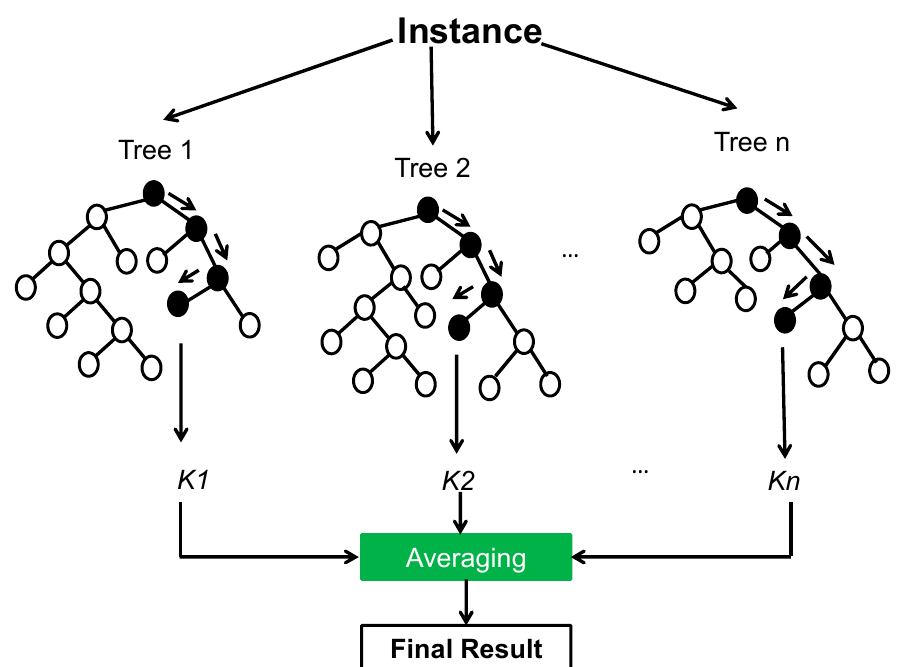
Figure 2. Fundamental design of the RF algorithm.